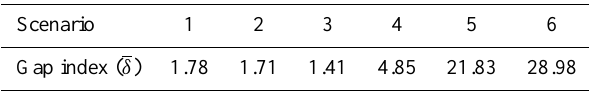
Table 4. The total gap index under optimized reed harvest scheme for each